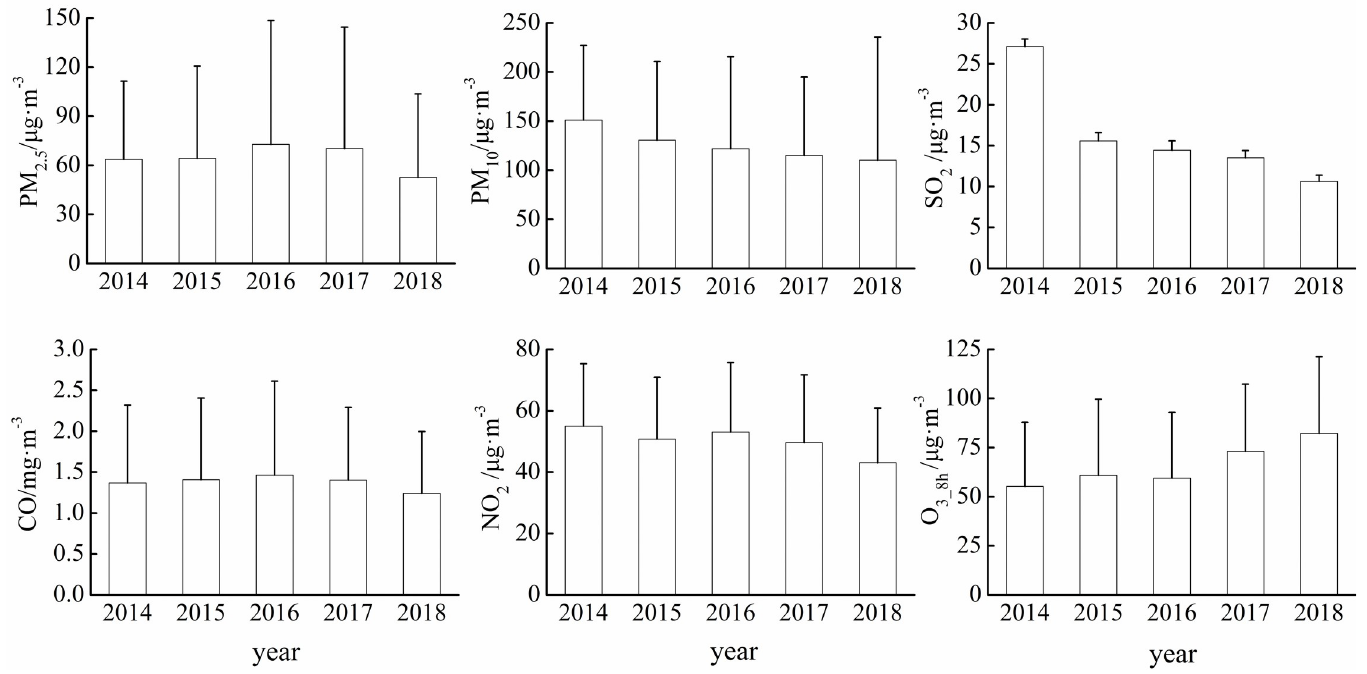
Fig 2. Inter-annual variations of major air pollutants in